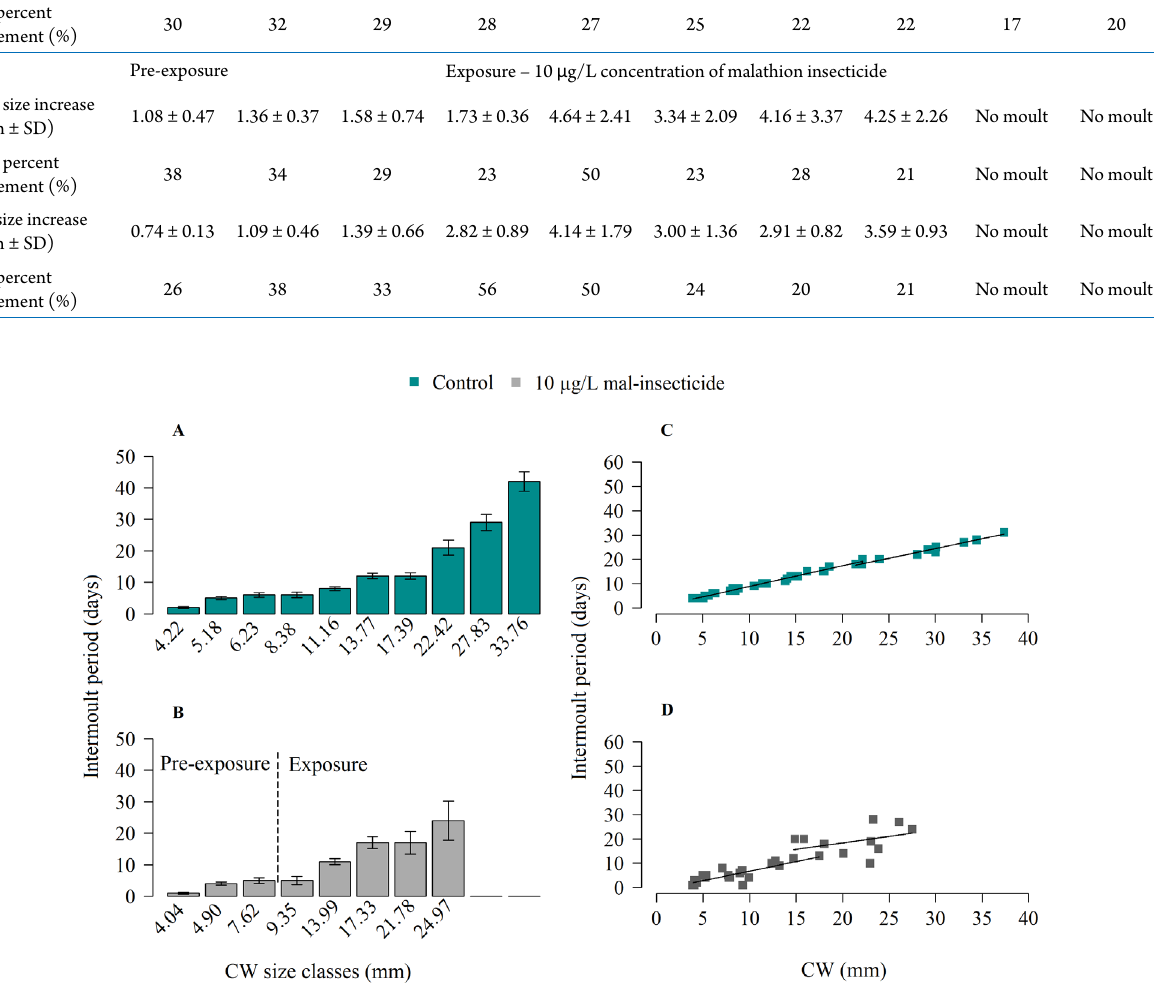
Figure 1. Growth aspects for Poppiana dentata in relation to: mean intermolt period and CW size classes of control ( A ) and malathion- exposed ( B ) crabs over the 5-month period; intermolt period and carapace width (CW) for control ( C ) and malathion-exposed ( D ) crabs. Error bars in A and B plots represent the standard errors for the intermolt periods. The dashed line in B separates pre-exposure (no pesticide) conditions for the malathion-exposed cohort and exposure to the malathion insecticide at 10 µg/L concentration. Breakpoints in C and D are denoted by segmented lines for the respective